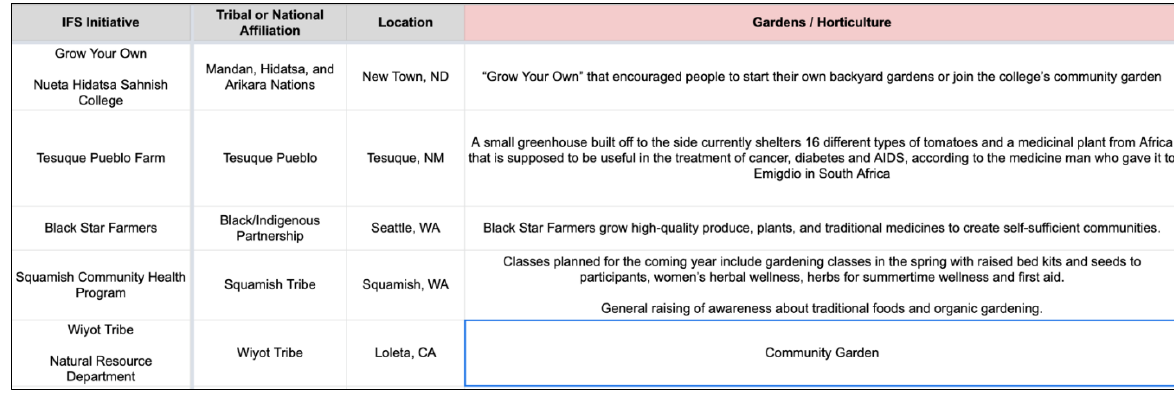
Figure 2. Western U.S. Indigenous Food Sovereignty (IFS) Initiatives and Key Features Inventory Database